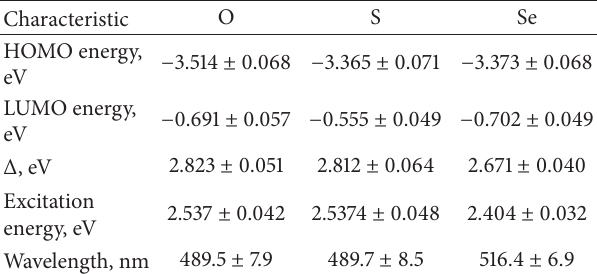
Table 2: Mean values and confidence intervals of quantum char- acteristics for [ 1,2,5 ] oxadiazolo [ 3,4- c ] pyridine (O), [ 1,2,5 ] thiadia- zolo [ 3,4- c ] pyridine (S), and [ 1,2,5 ] selenadiazolo [ 3,4- c ] pyridine (Se) derivatives.